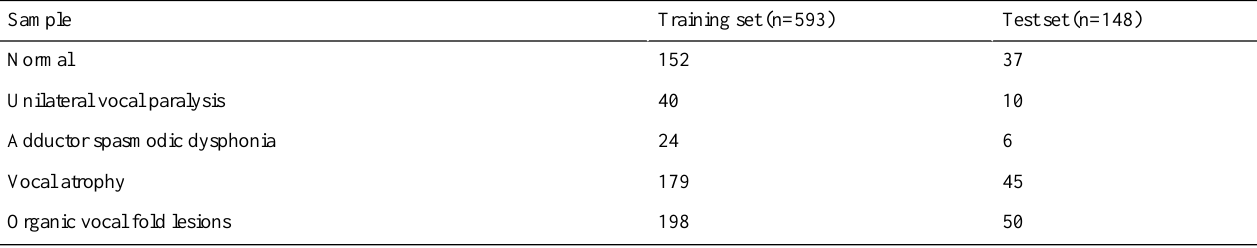
Table 1. Details of the voice samples used for experiments